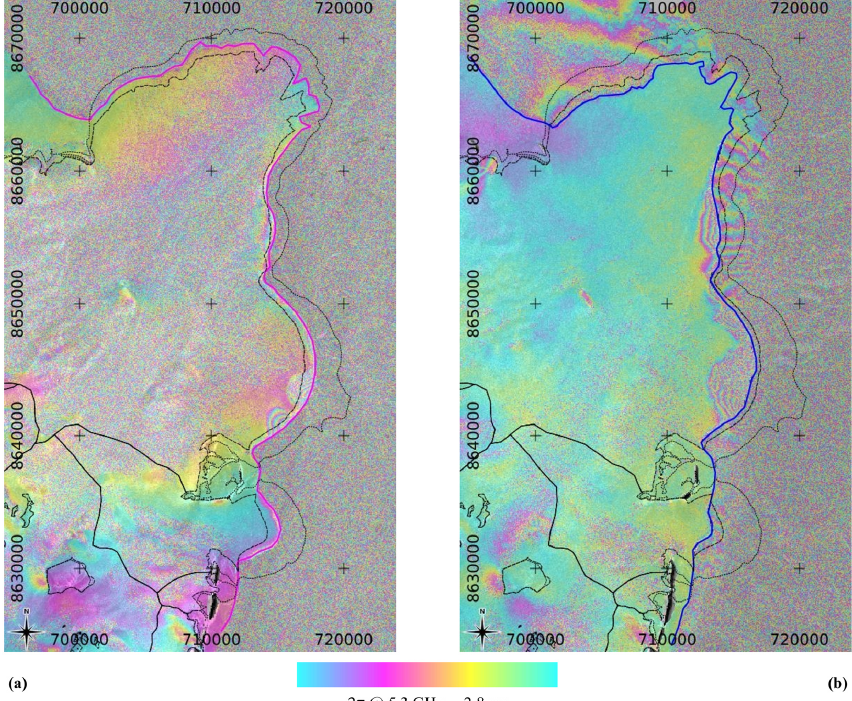
Figure 4. Differential SAR interferograms from (a) ERS-1 data of 2 January 1994 and 5 February 1994 and (b) ERS-2 data of 22 March 2011 and 25 March 2011. Image background is a backscattering intensity image of the master scene used for interferometry. The coastal outline on the year of the SAR images is shown along with glaciers inventories of 1971 (dotted line) and 2006–2007 (RGI 5.0, dashed